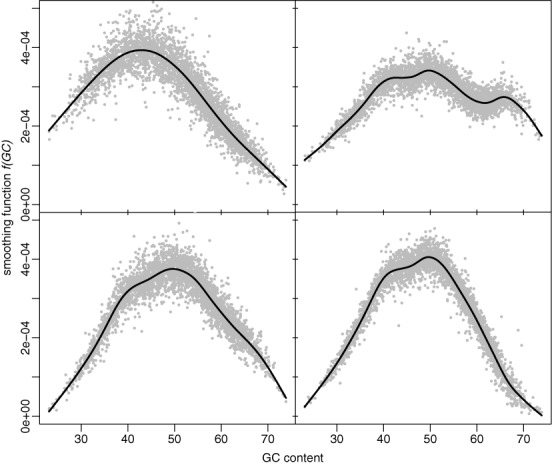
Predicted values of \documentclass[12pt]{minimal}
\usepackage{amsmath}
\usepackage{wasysym}
\usepackage{amsfonts}
\usepackage{amssymb}
\usepackage{amsbsy}
\usepackage{upgreek}
\usepackage{mathrsfs}
\setlength{\oddsidemargin}{-69pt}
\begin{document}
}{}$f(GC)$\end{document} for four samples from the 1000 Genomes Project data set. Most patterns agree with previous observations that read depth has a unimodal relationship with GC content. However, dual modality is also observed. Furthermore, the function changes in shape and not just by a scaling factor.